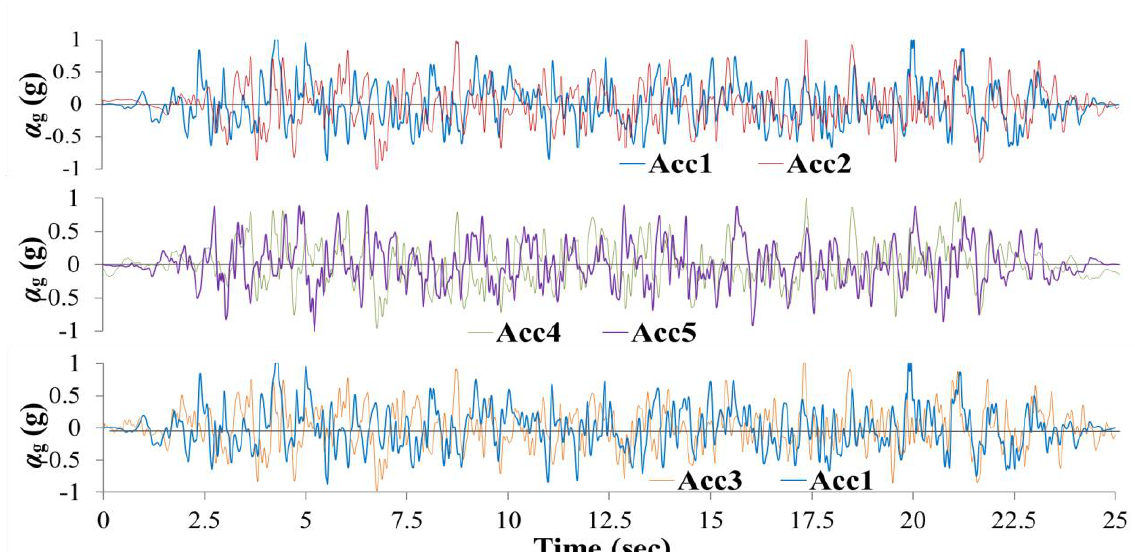
Fig. 6. Three pairs of unit-normalized artificial accelerograms ( a